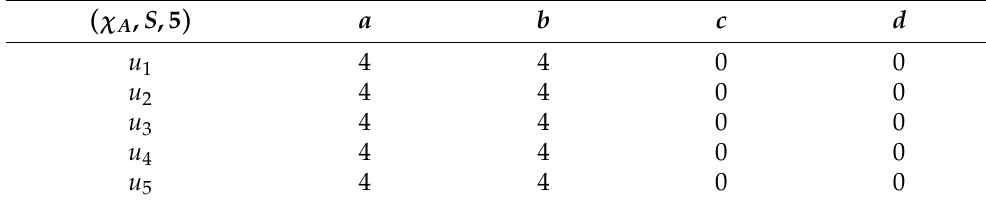
Table 13. The 5-Soft Set of ( χ A , S ,5 )